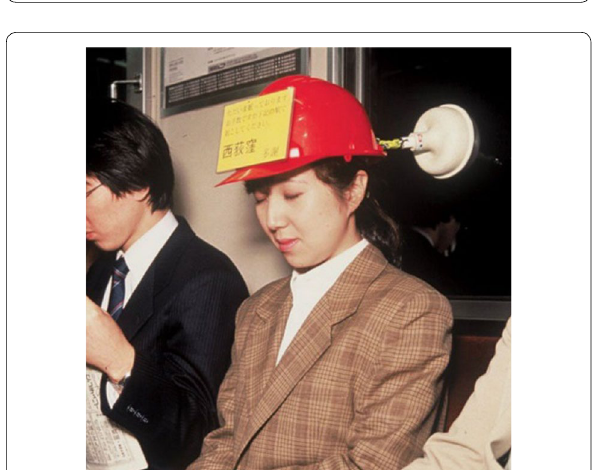
Fig. 4 The subway sleeper. Source: https ://www.tofug u.com/japan / chind ogu-japan ese-inven tions